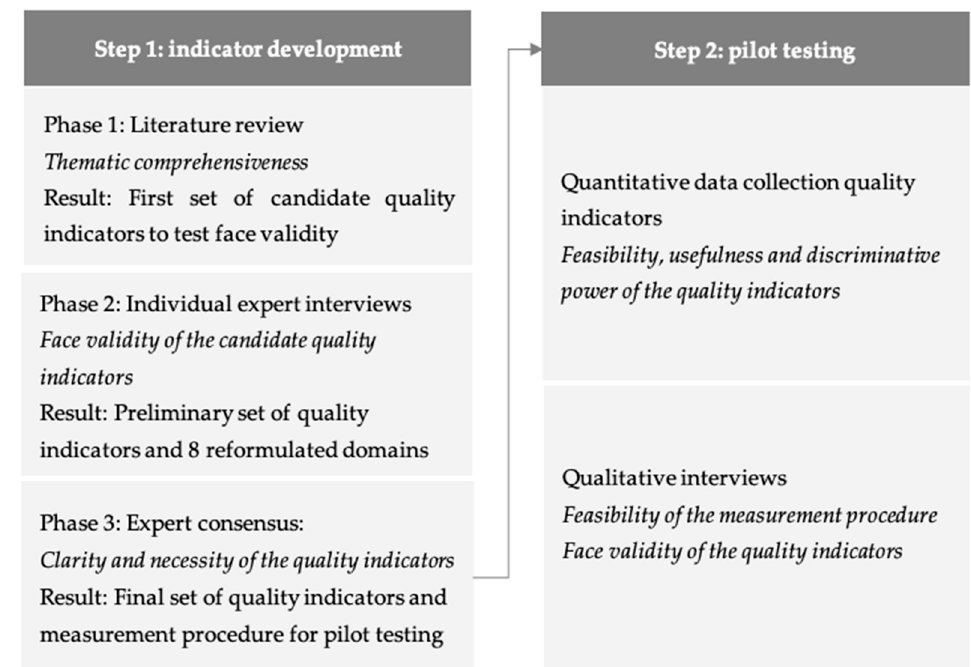
Figure 1. Overview of study phases and accompanying results.